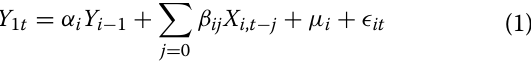
correlation coefficient exceeds